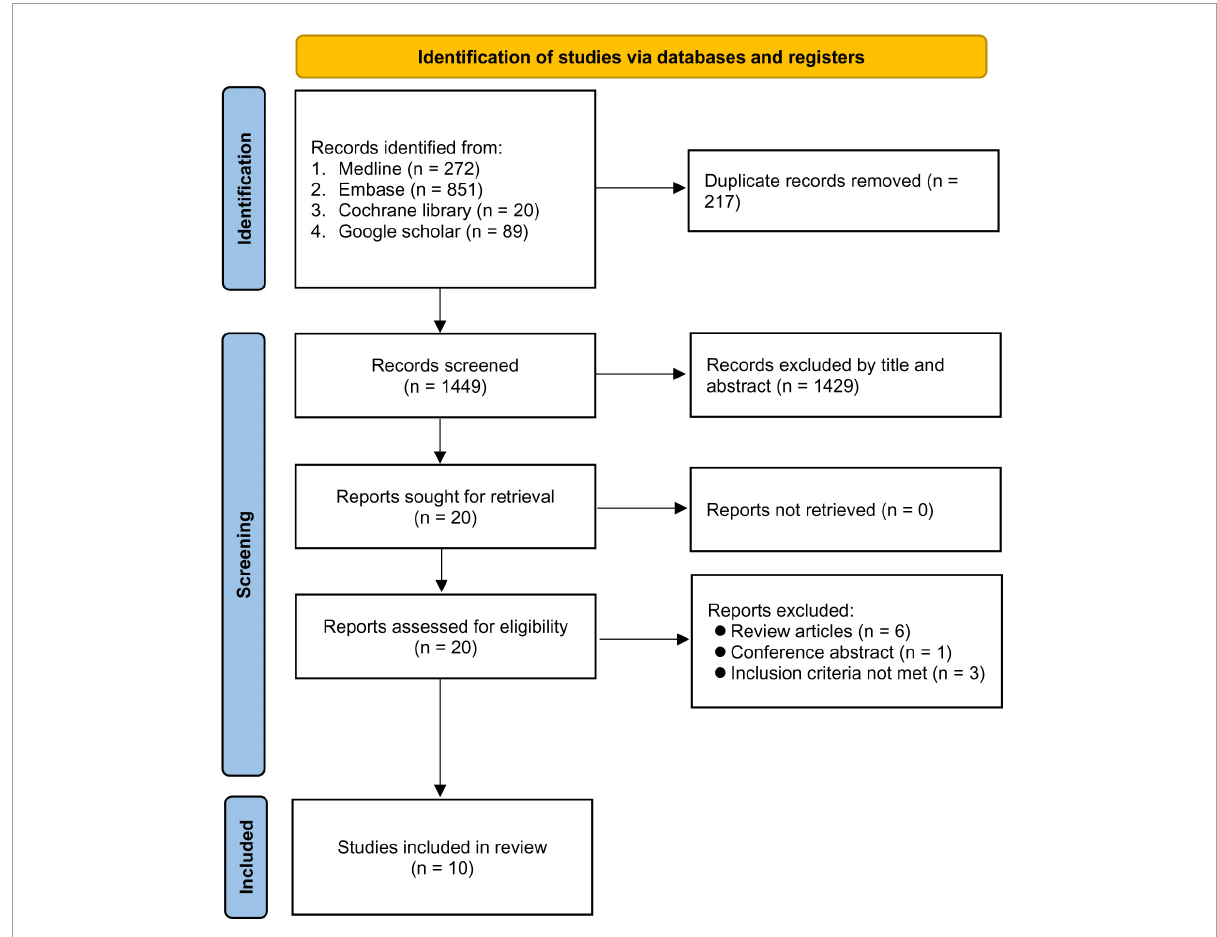
FIGURE1 PRISMA flow diagram of study